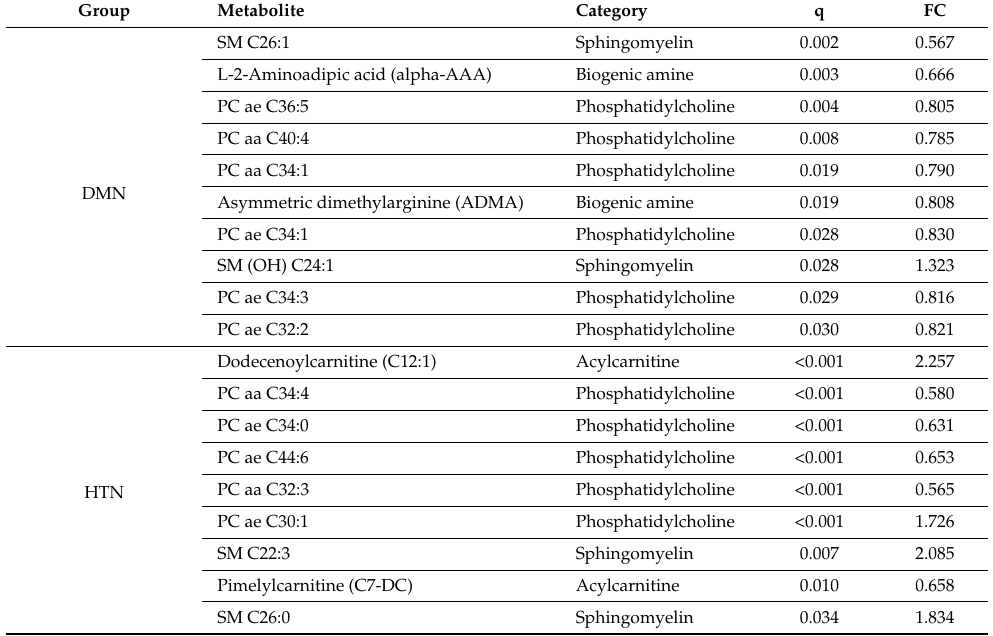
Table 2. List of the selected disease progression related biomarkers in each disease